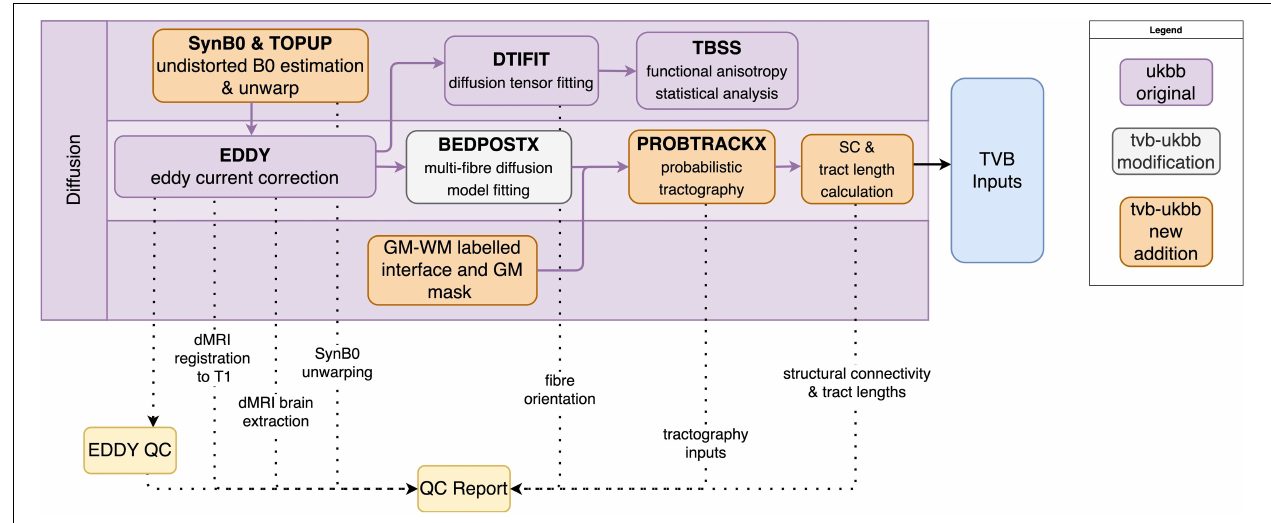
FIGURE 4 | Diffusion sub-pipeline workflow. Original components of the UK Biobank pipeline with few or no modifications shown in purple; pipeline components with major changes or additions shown in white; and new components shown in orange. Dotted lines indicate components that are included in the QC report. Black lines indicate components that are included in the TVB